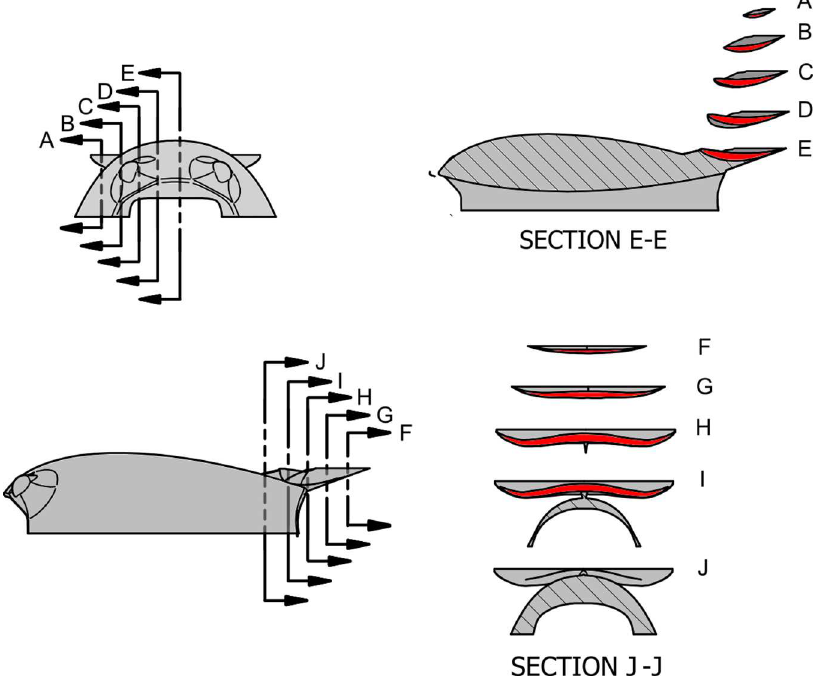
Fig 3. Detailed cross sectional views of the wing design. The cross sectionalsegment is highlightedin red. Top left: frontal view with section locations indicated. Top right: sections taken from the frontal view. Bottom left: side elevationwith section locationsindicated.Bottom right: sectionstaken from the side